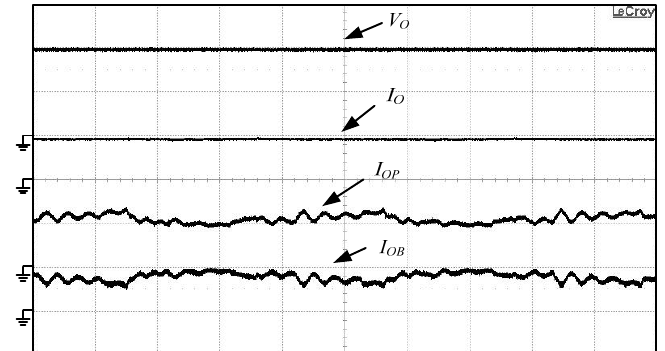
( V : 200 V/div, I O